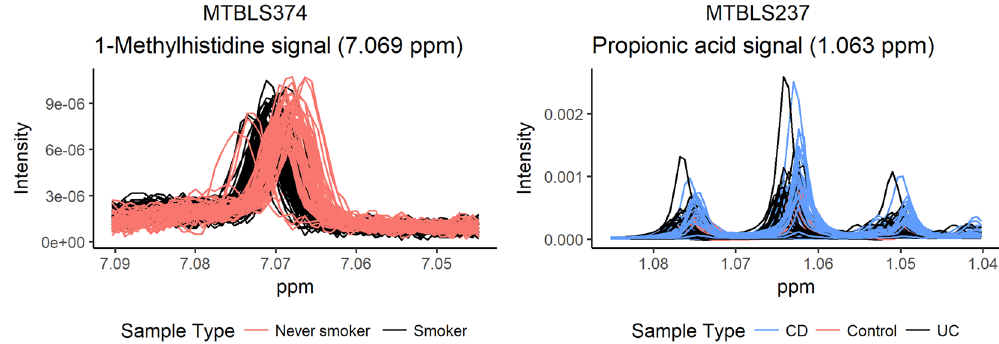
Figure 2. Signals can be misaligned in some sample classes. Low pH mediated by the condition studied increases the chemical shift of the signals. The resulting class-dependent signal misalignment can distort the results of the analysis of fingerprint data: features can show significant differences caused by differences in chemical shift (mediated by pH or ionic strength) rather than by differences in metabolite